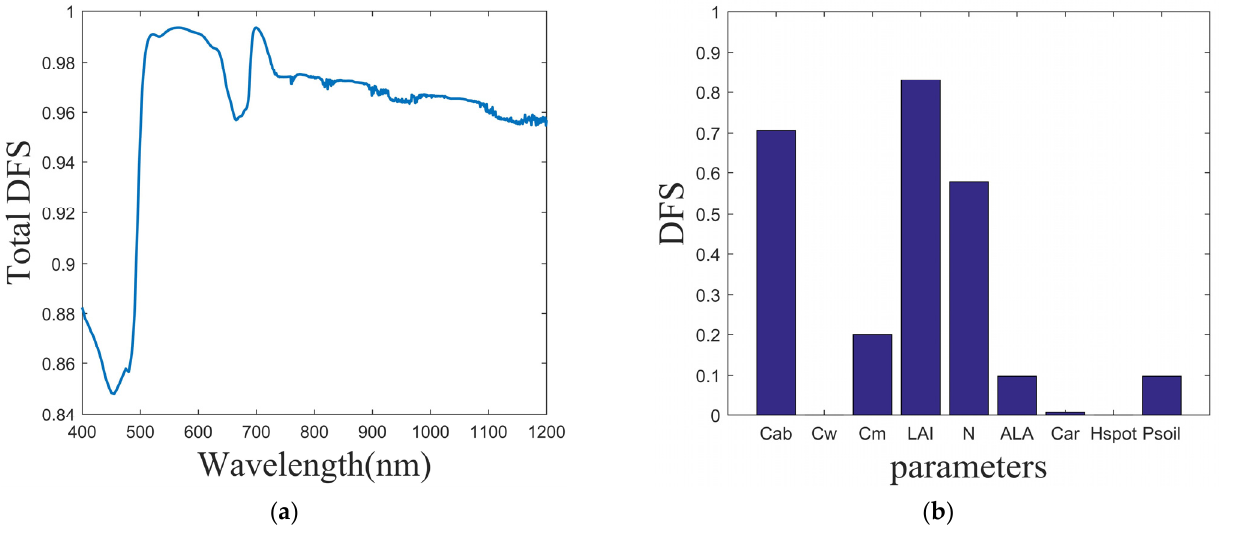
Figure 6. The DFS of crop parameters: ( a ) the DFS of different wavelengths for all parameters and ( b ) the DFS of five bands for each parameter.